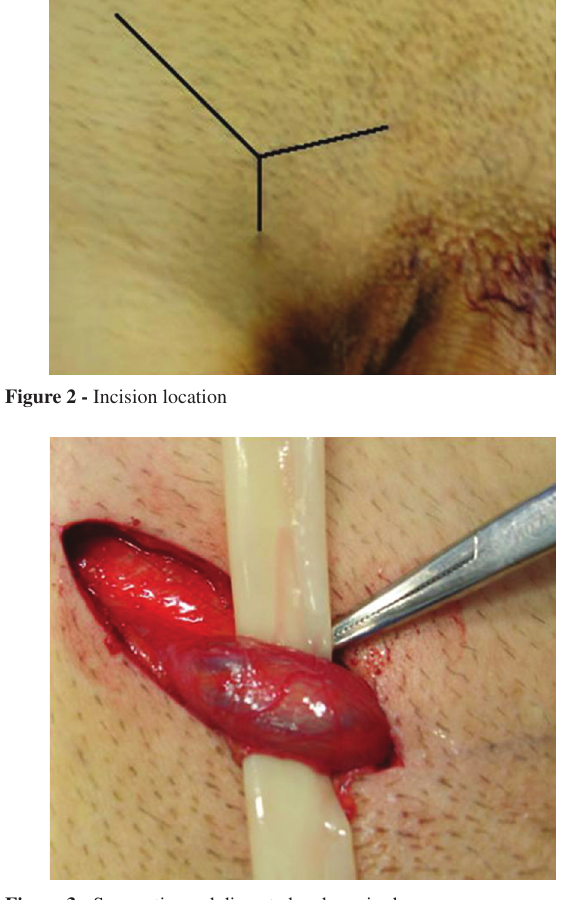
Figure 3 - Spermatic cord dissected and repaired